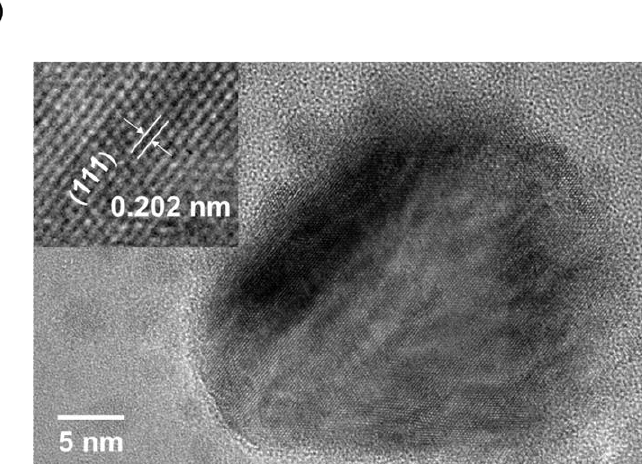
Figure 5. ( a ) TEM image of Ni/SiN400 sample showing Ni nanocrystallites formed in situ within amorphous silicon nitride matrix and inset presenting a size distribution histogram (statistics on 50 Ni nanocrystallites) measured by TEM, ( b ) a selected area electron diffraction pattern obtained for the Ni/SiN400 sample, and ( c ) a high-resolution image with the enlarged one